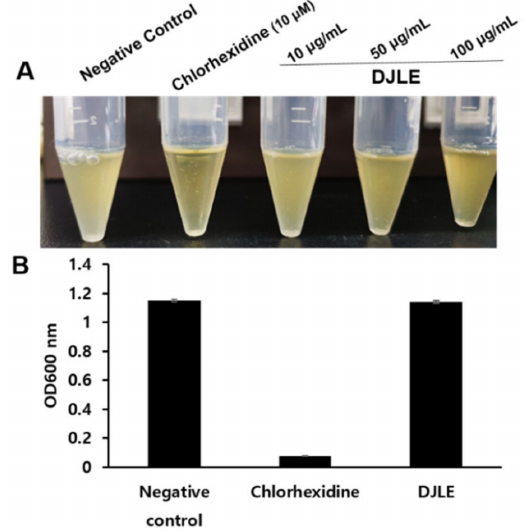
Figure 7. Growth inhibition effect of Daphne jejudoensis leaf extract (DJLE) against Porphyromonas gingivalis : the broth turbidity comparison with positive control, chlorhexidine ( A ), and the optical density at 600 nm ( B ).